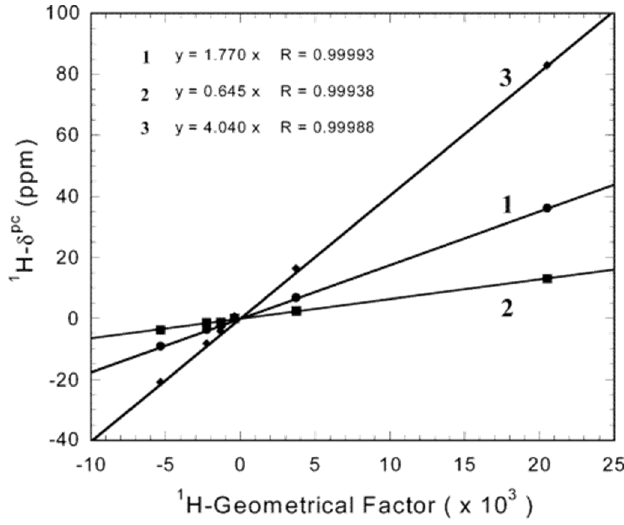
Figure 10. Relation between pseudocontact shifts and Geometrical Factors ( ( 3cos 2 θ − 1 ) / r 3 in Equation (5)) for Na 3 [Yb((S)-BINOL) 3 ] (1), K 3 [Yb((S)-BINOL) 3 ] (2), and Li 3 [Yb((S)-BINOL) 3 ] (3). Reproduced with permission from ref. [116], copyright 2003 American Chemical Society.